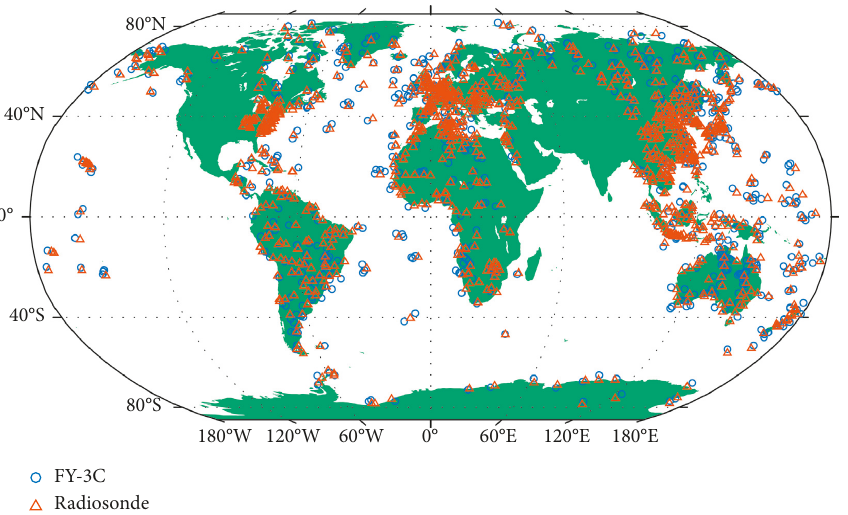
Figure 1: FY-3C occultation events and co-located radiosonde stations from September 21th to 28th, 2014.